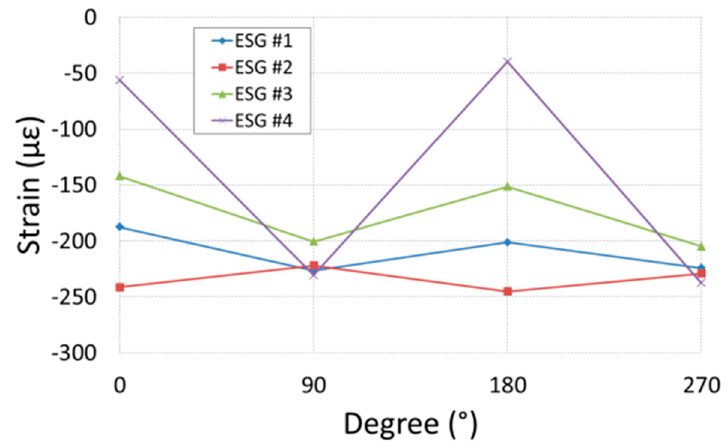
Figure 8. Strains from four strain gauges with a 10 t load due to the placing angles of the bearing plate in the fixing jig.